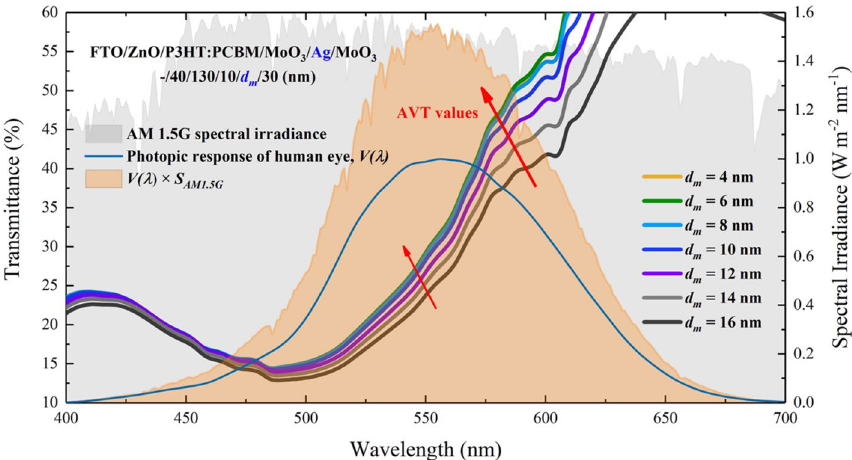
Figure 6. Transmittance spectra of FTO/ZnO/P3HT:PCBM/MoO 3 /Ag/MoO 3 . (–/40/130/10/ d m /30 nm) ST-OSC according to d m and analysis of AVT values under V ( (cid:31) ) , AM 1.5G and V ( (cid:31) ) orange shaded area is related to the change of V ( (cid:31) ) denominator of Eq. (15).